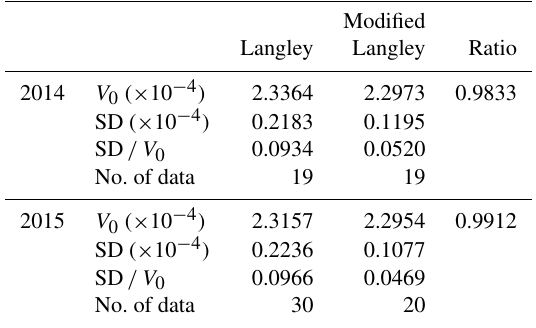
Table 7. Same as Table 6 but using the data taken at Tsukuba,